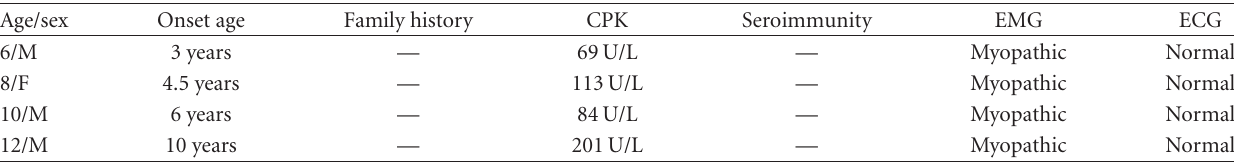
Table 1: Results from clinical, laboratory, and ancillary investigations of the four patients (the normal value of CPK should be less than 183U/L).